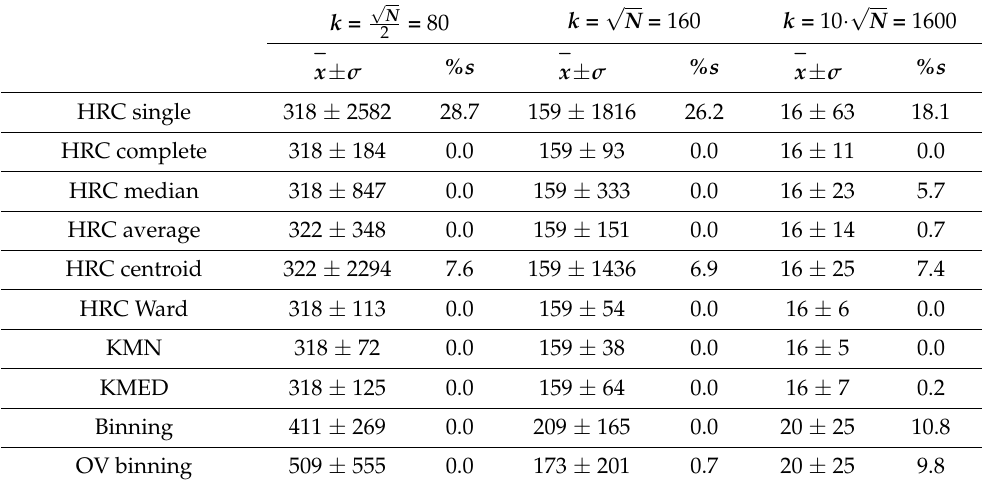
Table 2. Population distribution per cluster ( k ) analysis in Tafenoquine’s analogs’ chemical space, varying the clustering standard sizes. The mean value ( x ) of the population frequencies per cluster and its subsequent standard deviation ( σ ), along with the ratio of singletons to number of clusters ( %s ), are considered in